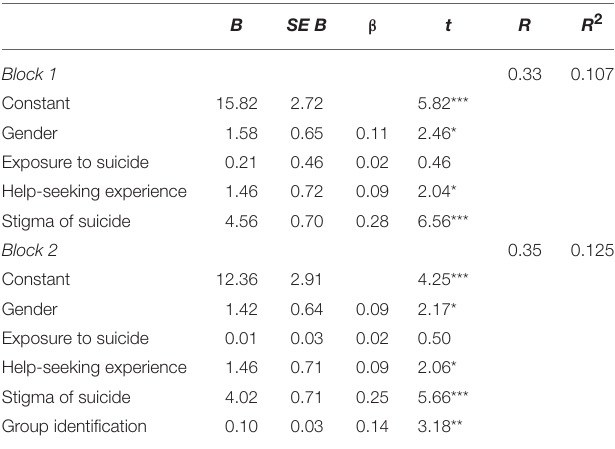
TABLE 3 | Hierarchical regression coefficients for variables predicting stigma of